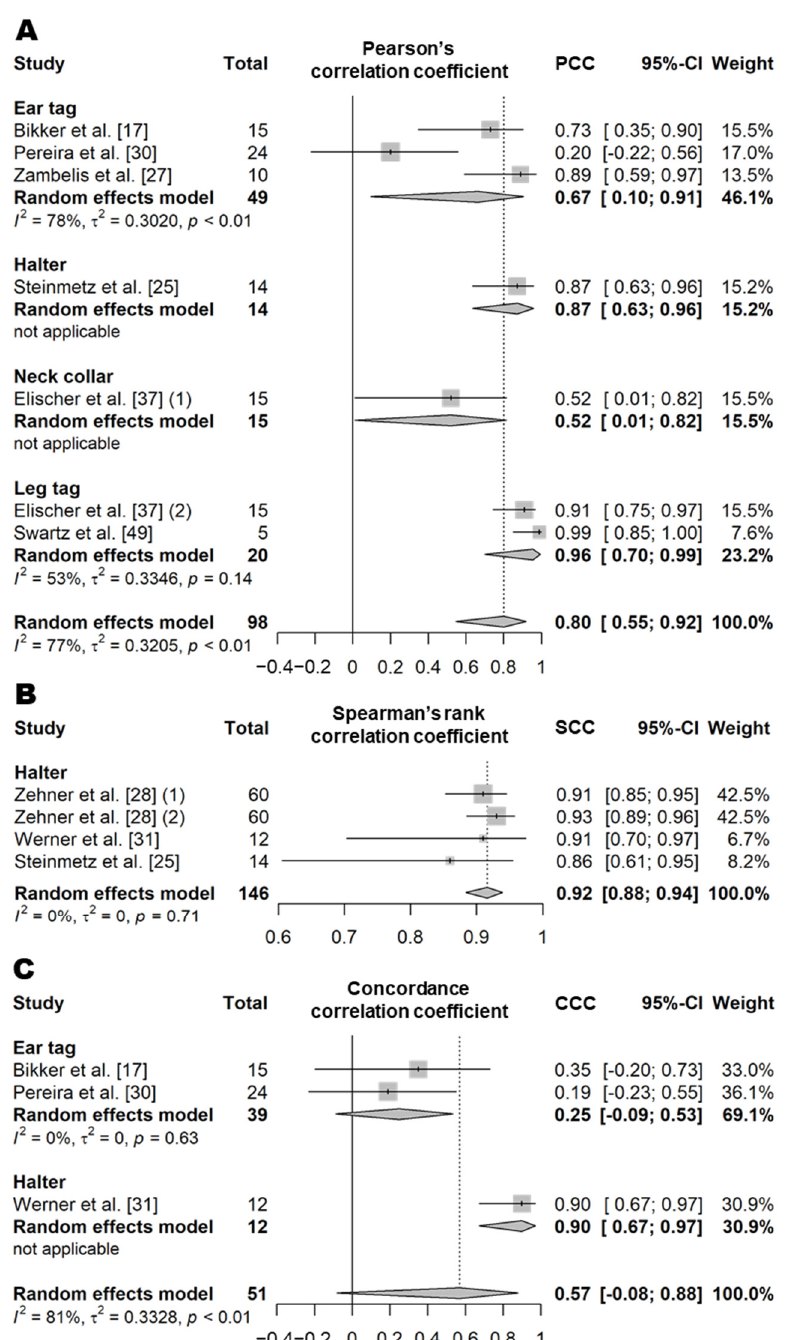
Figure 10. Forest plot of the correlation coefficient of active time between wearable sensors and visual observation. ( A – C ) show Pearson’s correlation coefficient, Spearman’s correlation coefficient, and concordance correlation coefficient, respectively. Numbers in parentheses indicate individual studies applying different evaluation conditions within the same article. ‘Total’ means the sample size of each study and ‘Weight’ means the weight for the mean based on the sample size.